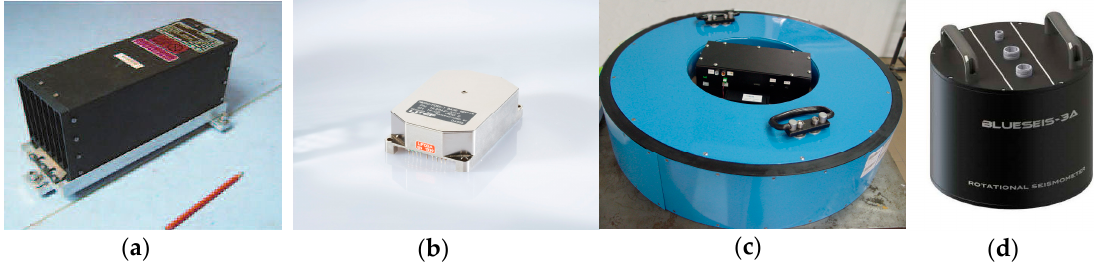
Figure 9. Rotational seismometers based on FOG: ( a ) LCG-demonstrator [40]; ( b ) μ FORS-1 [89]; ( c ) AFORS-1; ( d ) BlueSies-3A [93].